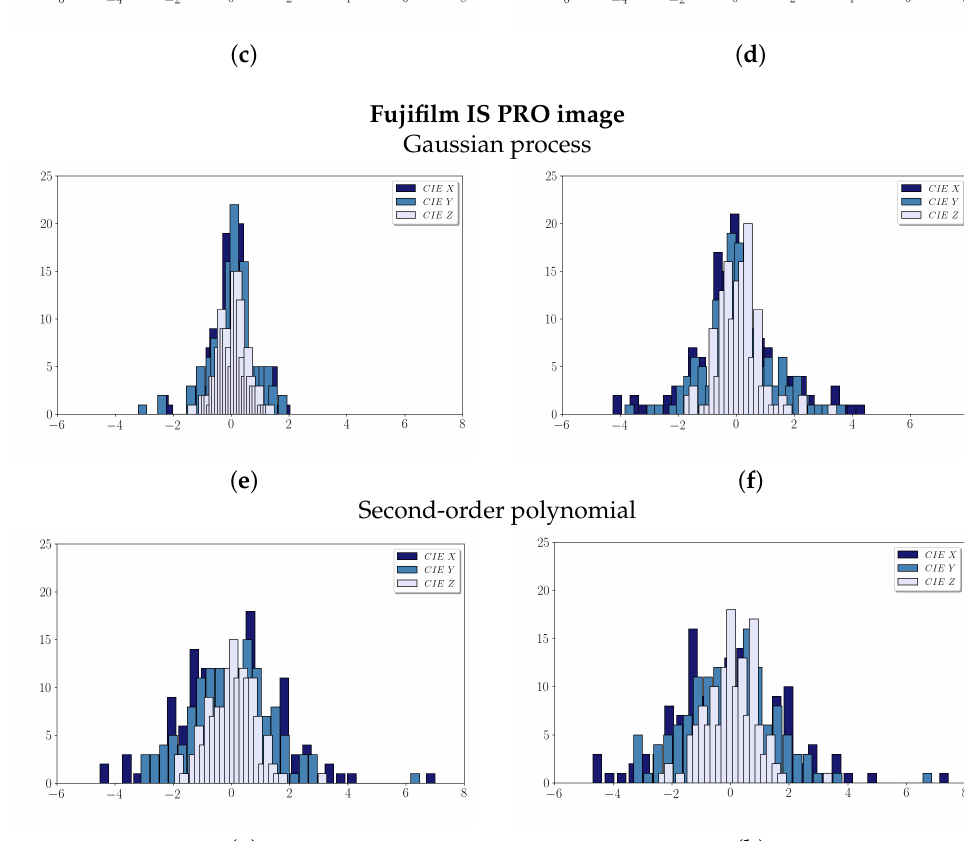
Figure 3. CIE XYZ residuals histograms after the adjustment: ( a , b , e , f ) Gaussian process; ( a , d , g , h ); Second-order polynomial; ( a , c , e , g ); CIE XYZ residuals; ( b , d , f , h ); LOOCV